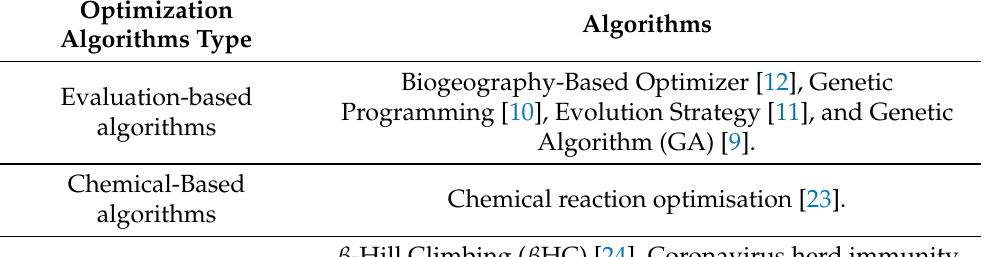
Table 1. Nature-inspired